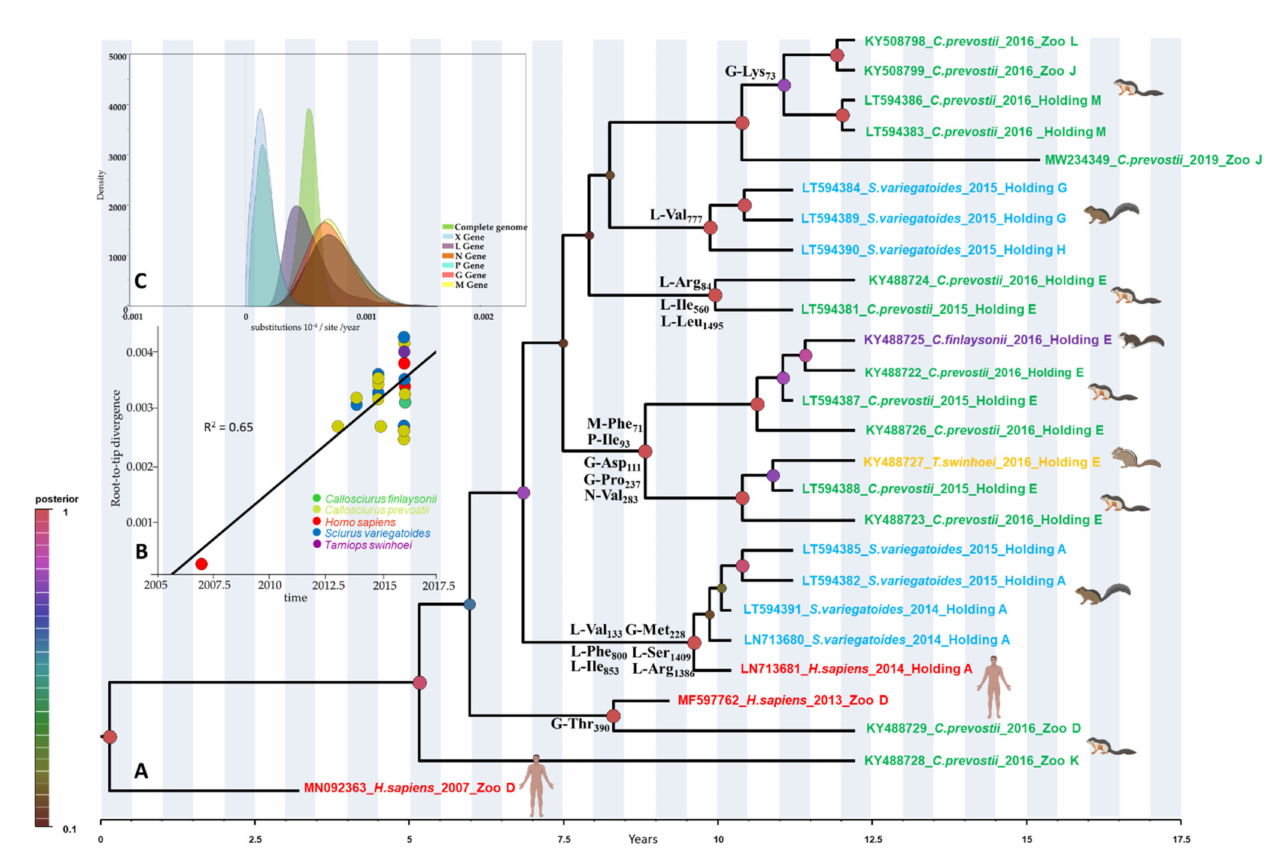
Figure 1. Phylogeny, sequence relatedness and micro-evolutionary rate of variegated squirrel bornavirus 1 (VSBV-1). ( A ) Bayesian maximum clade credibility (MCC) tree representing the timescale phylogeny reconstruction of VSBV-1. Bayesian posterior probabilities are indicated as colored circles at the nodes (see color codes). Time elapse is shown in the axis below the tree. Taxon information includes GenBank accession number, host, year of detection and origin. The fixed amino acid substitutions which determine the clustering of the groups are shown at the node of respective group. The first letter represents the protein in which the substitution occurred, followed by the amino acid change and its position in the respective protein. The silhouettes were created with BioRender.com. ( B ) Root-to-tip linear regression divergence plot of the VSBV-1 genome versus sampling year. ( C ) Estimates of micro-evolutionary rates (subs site − 1 year − 1 ) and 95% credible intervals for the complete genome and each gene of